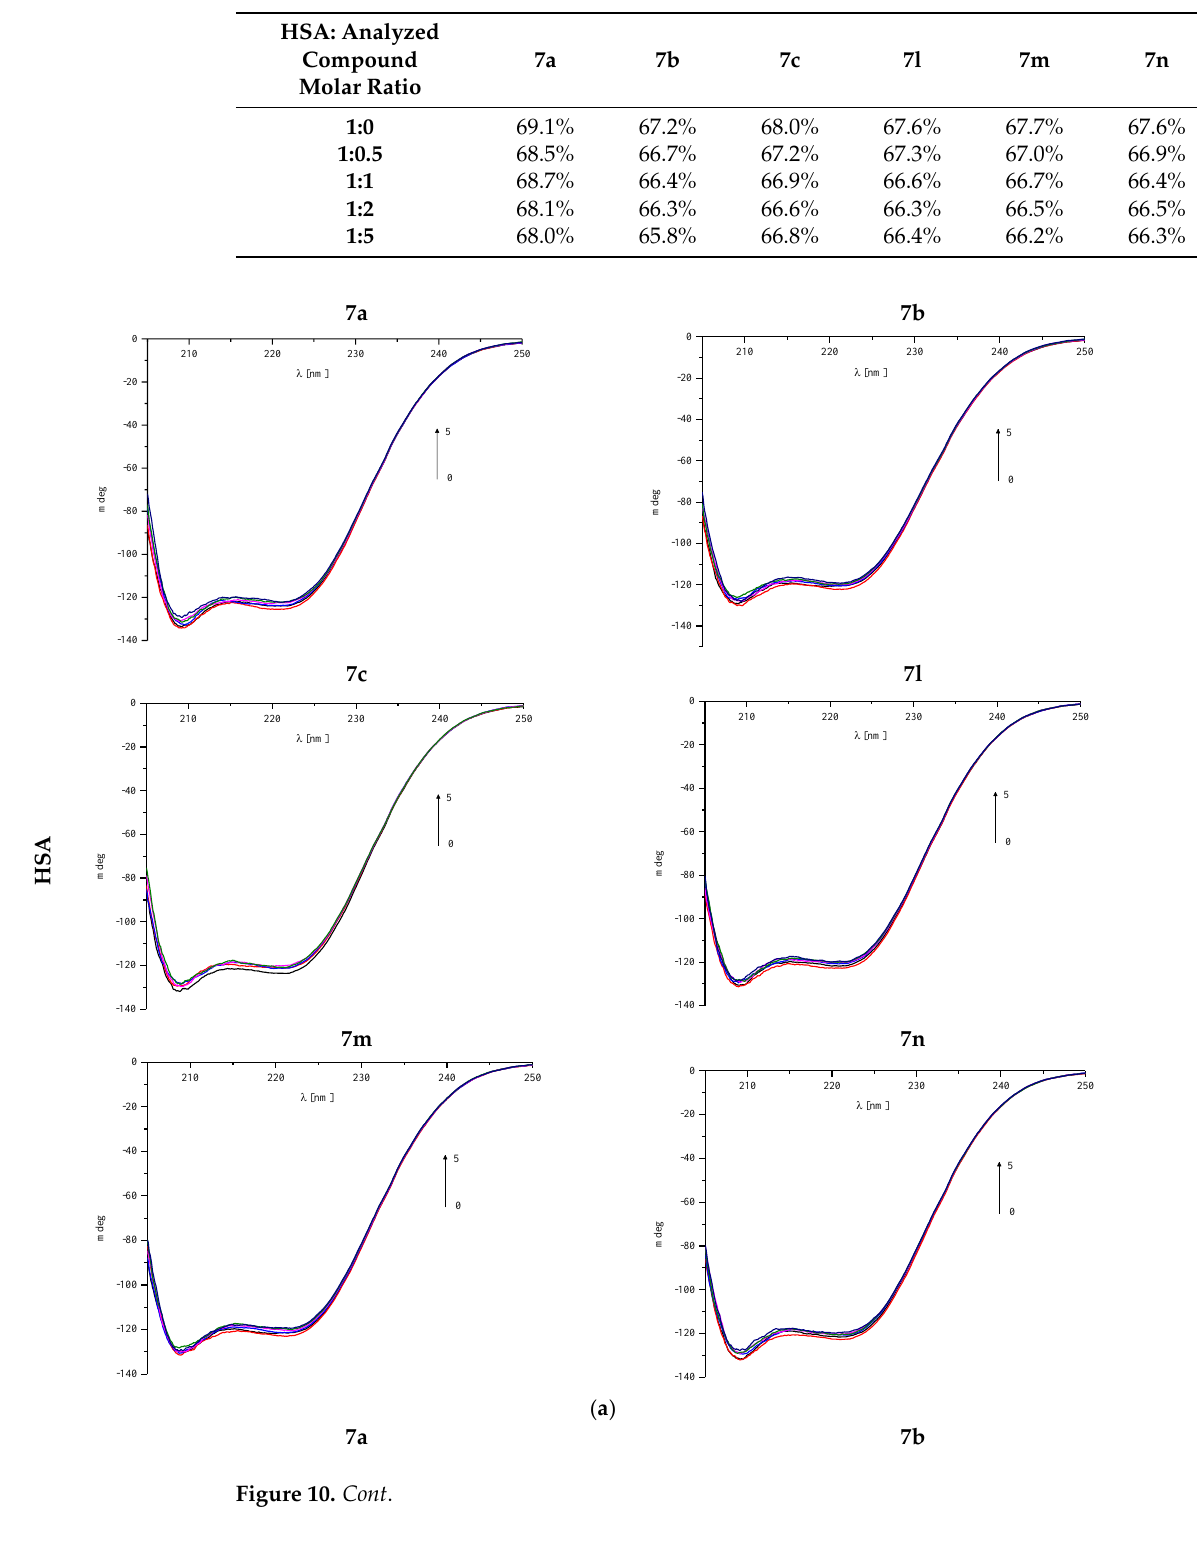
Table 11. Percentage of content of α -helix in human serum albumin (HSA) in the absence and presence of compounds 7a – 7c and 7l – 7n , calculated in the CD Multivariate SSE program.